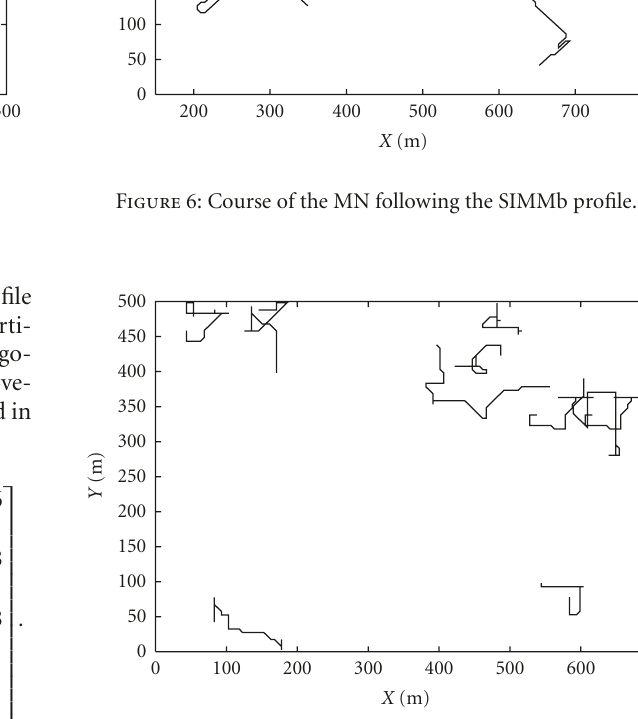
Figure 7: Courses of the various MNs using the SIMMc profile.